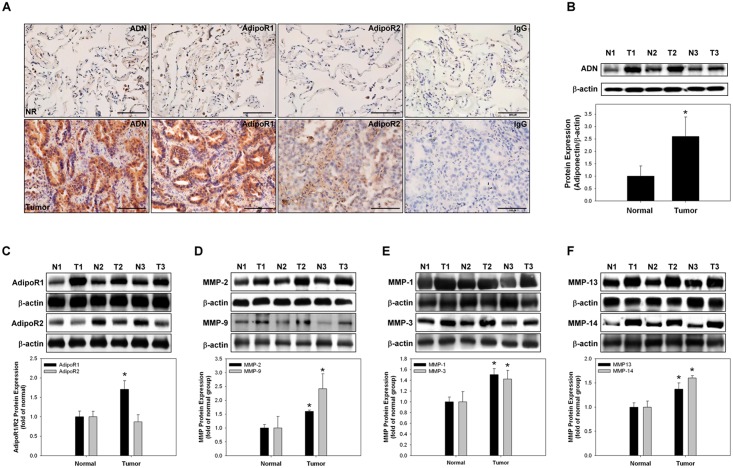
Expression levels of adiponectin, adiponectin receptor 1, adiponectin receptor 2, and matrix metalloproteinases (MMPs) in non-small cell lung cancer tissues.(A) Samples (lung cancer and the corresponding normal adjacent lung tissues) were analyzed with antibodies to adiponectin, adiponectin receptor 1, and adiponectin receptor 2 by immunohistochemical staining (DAB staining and hematoxylin counterstaining). For negative controls, the antibody was replaced with control IgG. (B-C) Expression levels of adiponectin, adiponectin receptor 1, and adiponectin receptor 2 in three pairs of lung cancer and normal tissues analyzed by western blotting. (D–F) Gelatin zymography was used to analyze the activities of MMP-2/MMP-9, MMP-1/MMP-3, and MMP-13/MMP-14. *p < 0.05 vs. normal lung tissue, with representative data from three different patients with NSCLC. T, tumor; N, normal; ADN, Adiponectin; AdipoR1, adiponectin receptor 1; AdipoR2, adiponectin receptor 2.